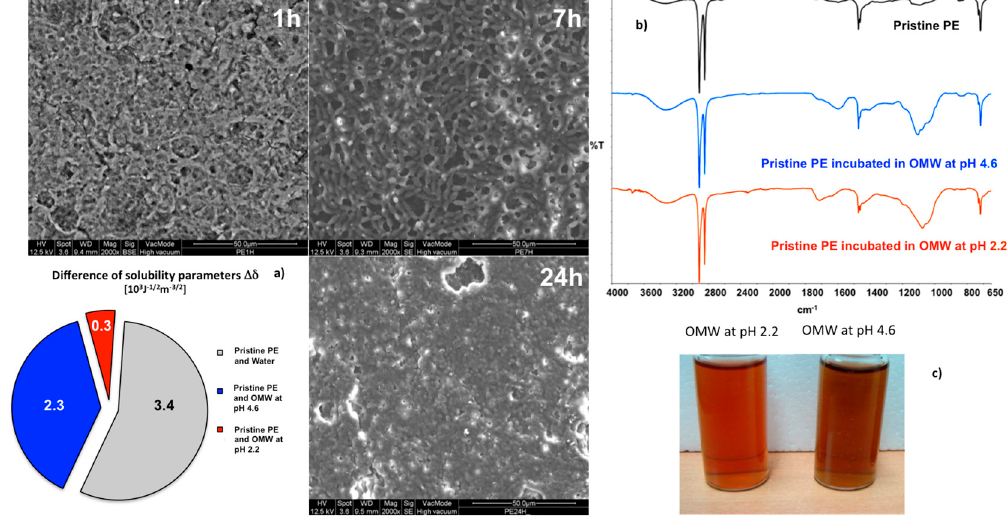
Figure 3. SEM micrograph collected onto the fouled PE membrane surface after 1, 7, and 24 h of incubation in olive mill wastewater (OMW) solution at pH 2.2 and related affinity with various solutions ( a ); ATR spectra collected onto PE membranes incubated in OMW 2.2 and OMW 4.6 ( b ); Picture related to OMW solutions at pH 2.2 and 4.6 ( c ).